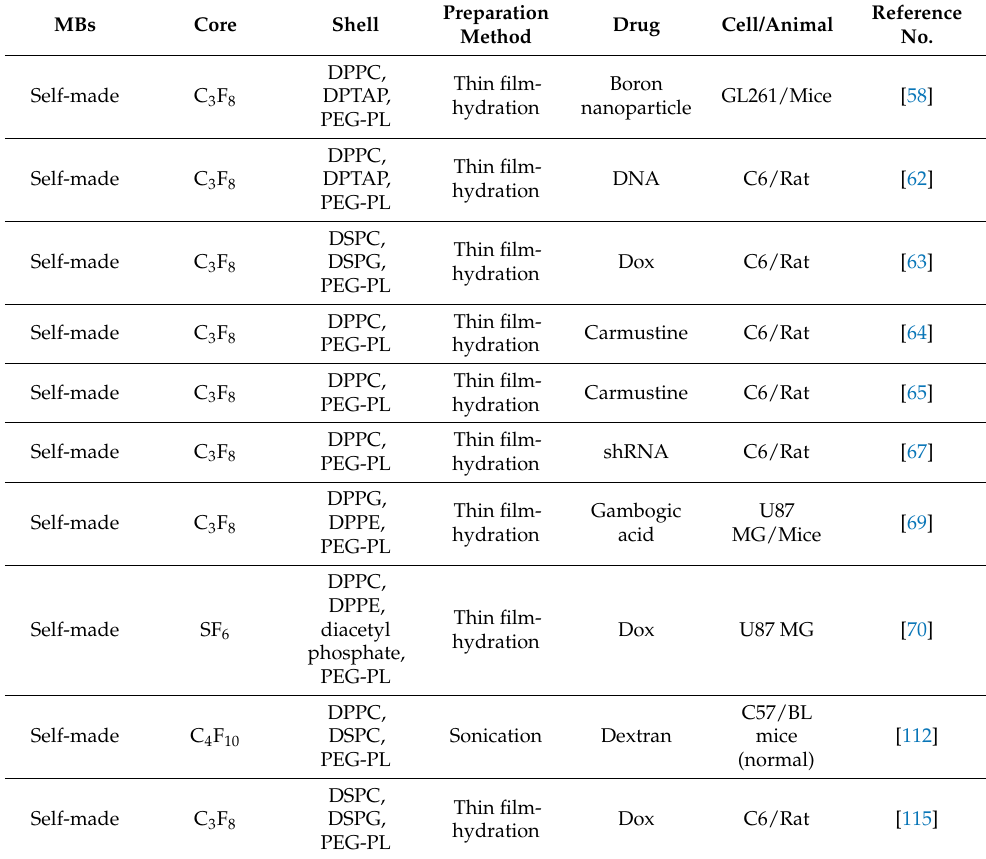
Table 2. Summary of the types of microbubbles, constituent materials, manufacturing methods, drugs, cells, and animals used for drug